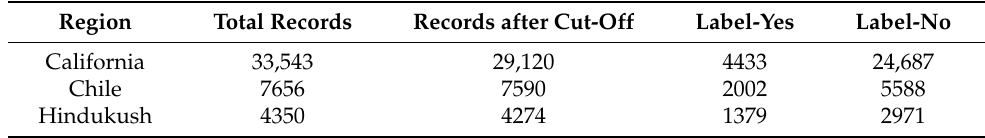
Table 1. Description of each